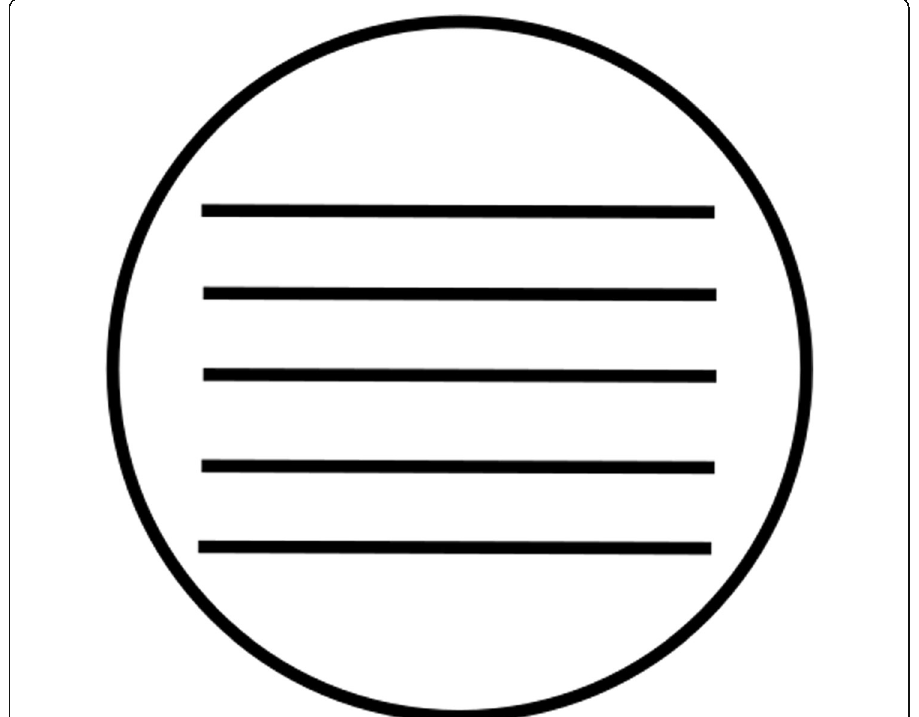
Fig. 2 Legend: The horizontal lines present the fragmented contributions of learners inside